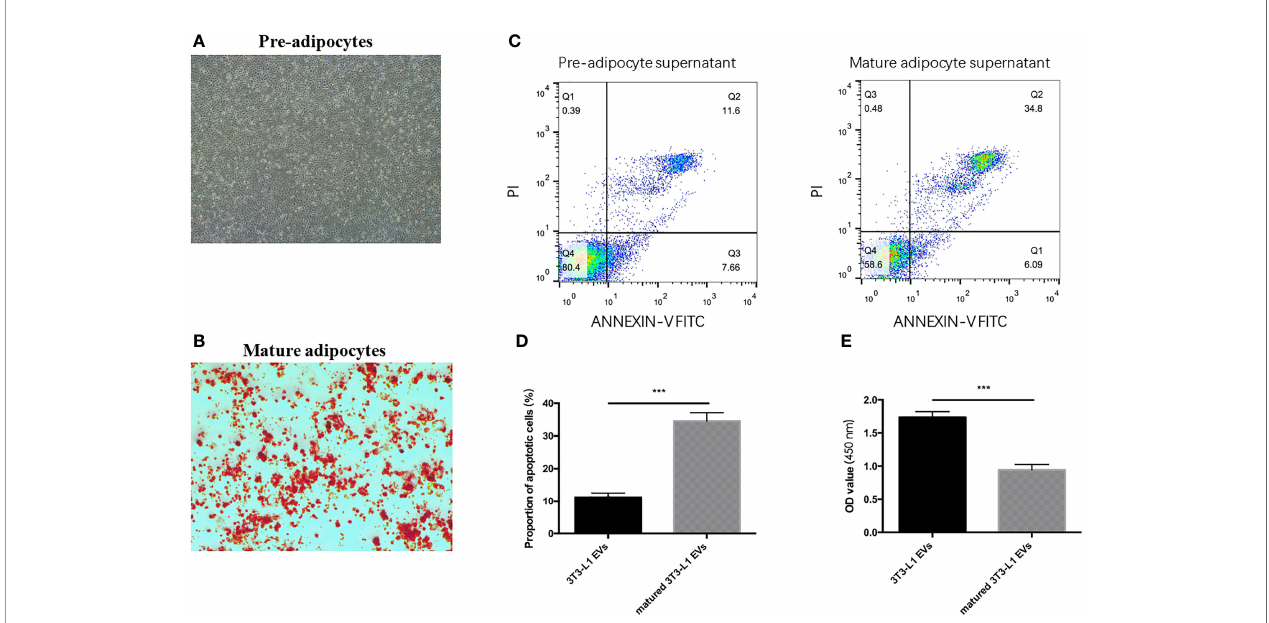
FIGURE 1 | Adipocytes inhibited CCs growth through paracrine route by stimulating apoptosis. (A) Representative images of Oil red O staining of pre-adipocytes. (B) Representative images of Oil red O staining of mature adipocytes. (C) Detecting the apoptosis of CC cells induced by pre-adipocytes supernatant (left) and mature adipocytes supernatant (right) via fl ow cytometry. (D) Quanti fi cation of the apoptosis detected via fl ow cytometry. (E) Detecting the viability of CC cells when co-cultured with pre-adipocytes supernatant and mature adipocytes supernatant via CCK8 assay; ***p <